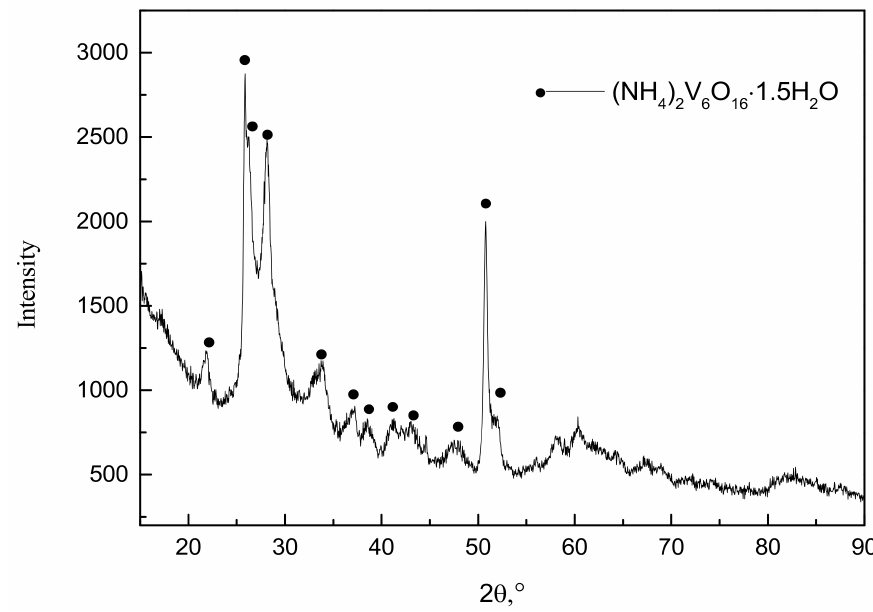
Figure 16. XRD pattern for the vanadium